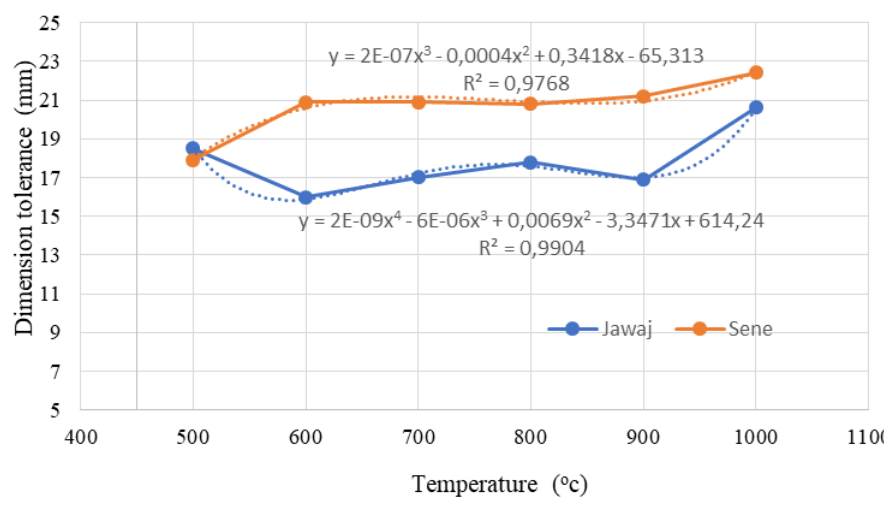
Figure 8: Average dimension tolerance test results along the length 240 mm.